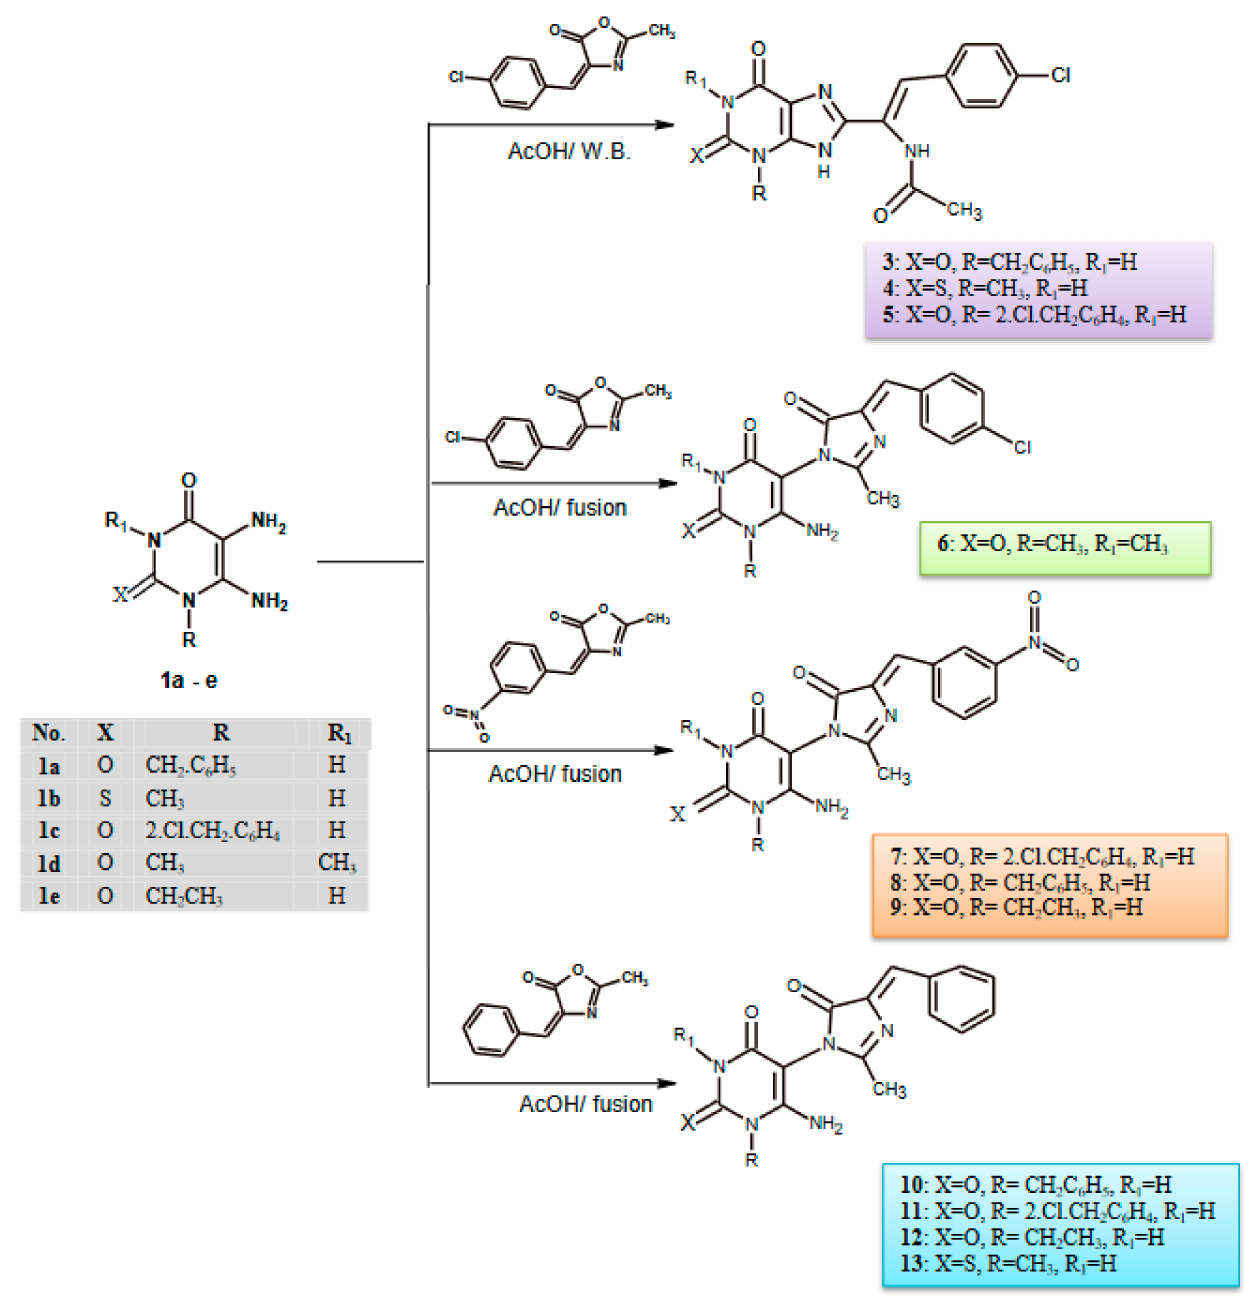
Scheme 4. The reaction of uracils with different azlactones 3-13